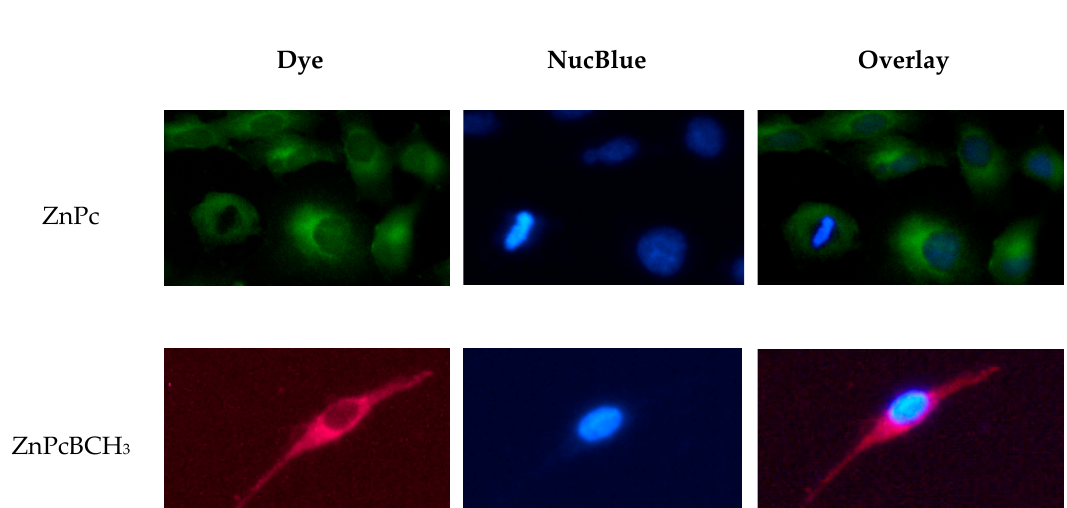
Figure 7. Subcellular distribution of ZnPC and ZnPcBCH 3 in A549 cells. After uptake the dyes were visualized using the Texas Red light cube for ZnPc, the Cy5 cube for ZnPc-BCH 3 and the DAPI cube for NucBlue.